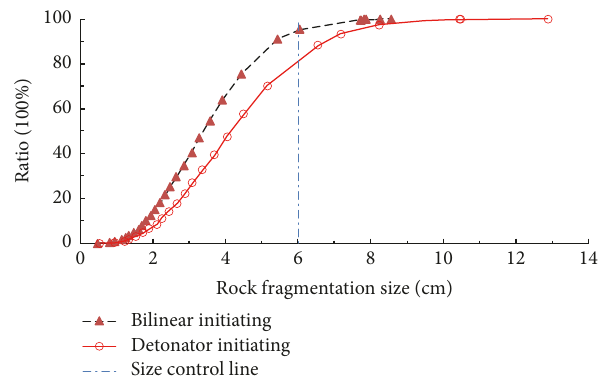
Figure 10: Rock fragmentation size of the field experiment.